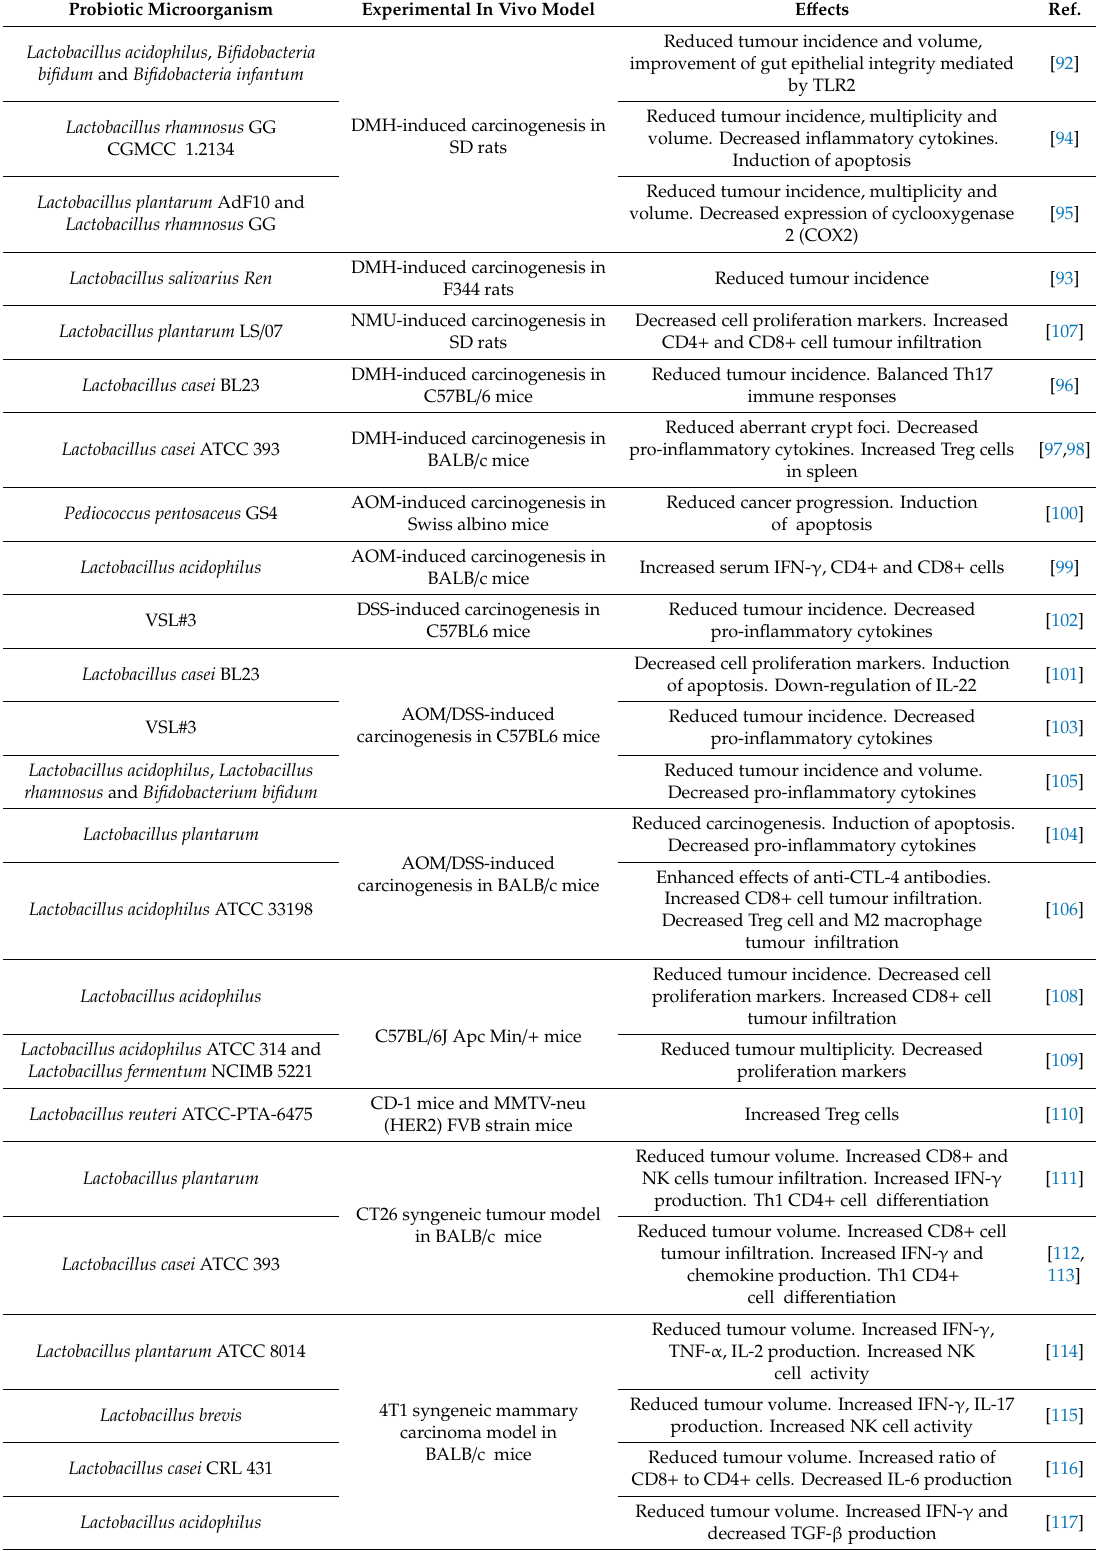
Table 1. E ff ect of probiotic strains in anticancer immune responses in experimental models in vivo. Probiotic Microorganism Experimental In Vivo Model